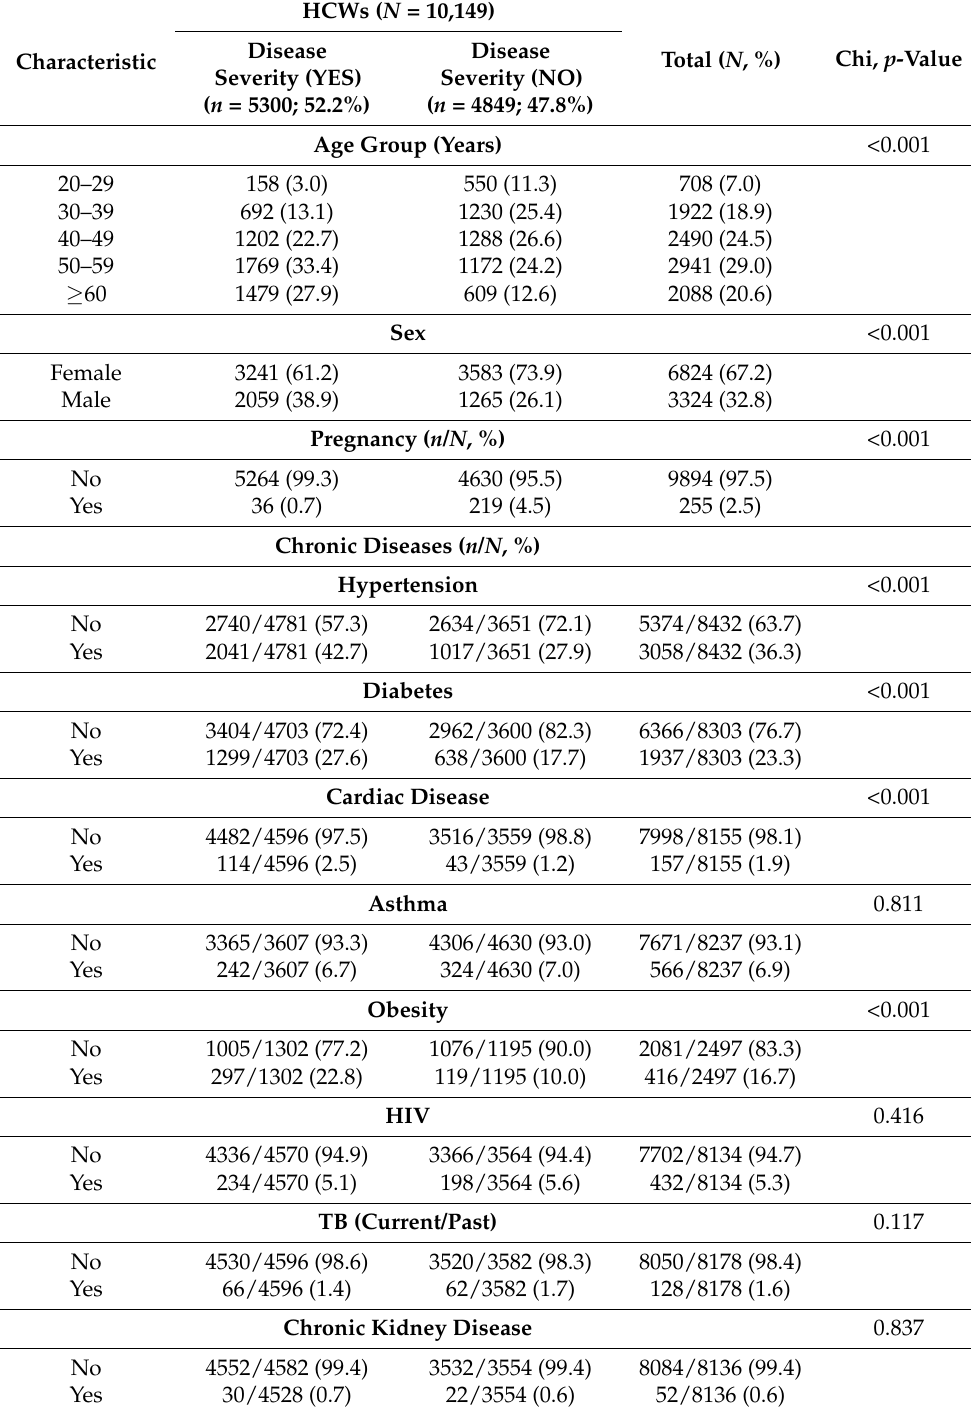
Table 1. Characteristics of admitted HCWs with severe and non-severe COVID-19 disease